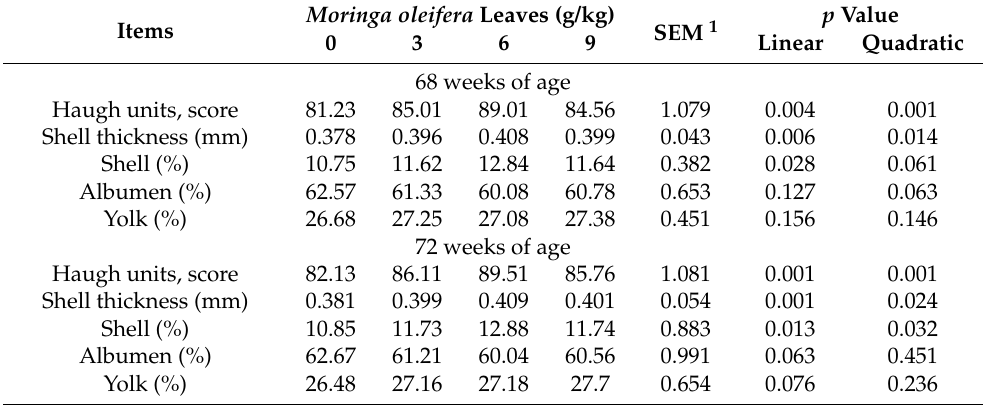
Table 4. The effect of Moringa oleifera leaves on egg quality of laying hens during the late laying period. Items